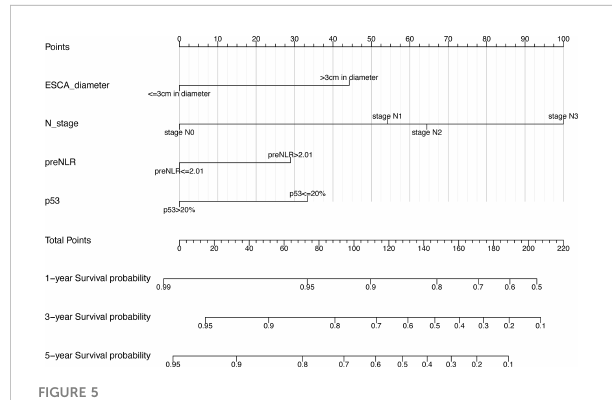
FIGURE 5 Nomogram. Nomogram prognostic model based on the best multivariate Cox regression